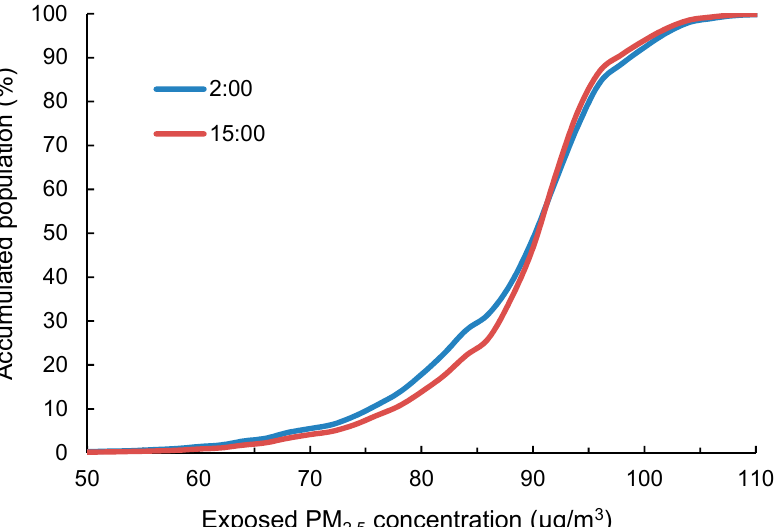
Figure 6. The change in the exposure curve due to the commute of the population. The line at 2:00 represents people at home addresses, and the line at 15:00 represents the working addresses after commuting.